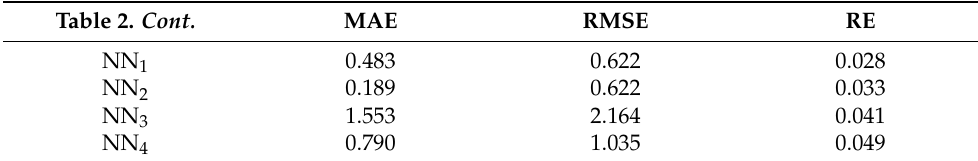
Table 2. Performance metrics following testing of the proposed ANN models using 5-fold cross-validation. Table 2.